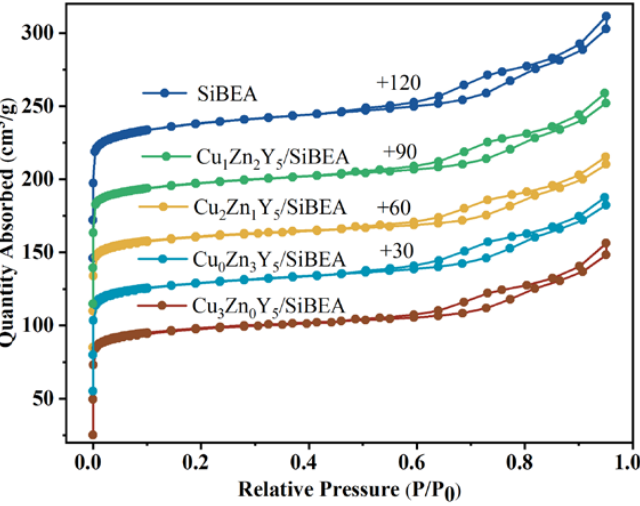
Figure 4. N 2 adsorption–desorption isotherms of SiBEA, CuZnY/SiBEA catalysts. Table 1. Specific surface area, pore volume, and pore size of SiBEA carrier and CuZnY/SiBEA catalysts.